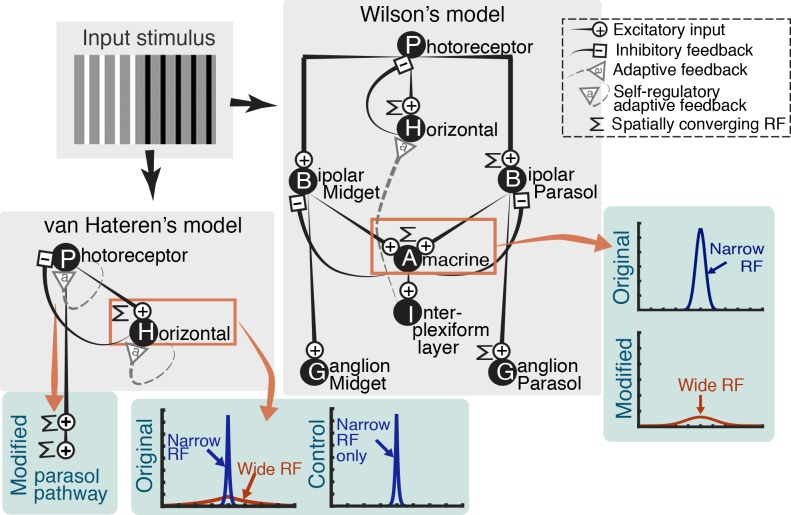
Diagrams of Wilson [36] and van Hateren [37,38] model structures and the modifications made to the models in the current study.Grey box shows the original versions of the models. Modifications made in the current study are shown in green boxes led by the red arrows. See text for details.